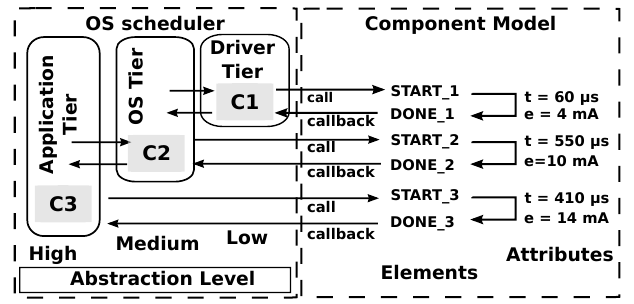
Figure 2. Model configuration using XML and hardware